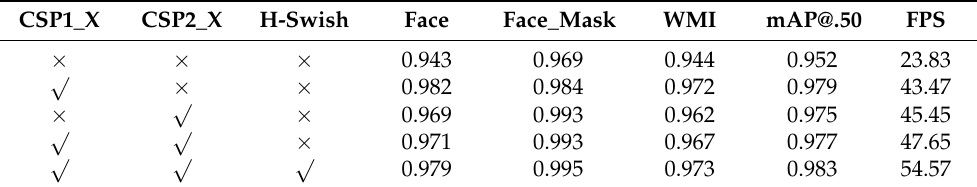
Table 12. Ablation